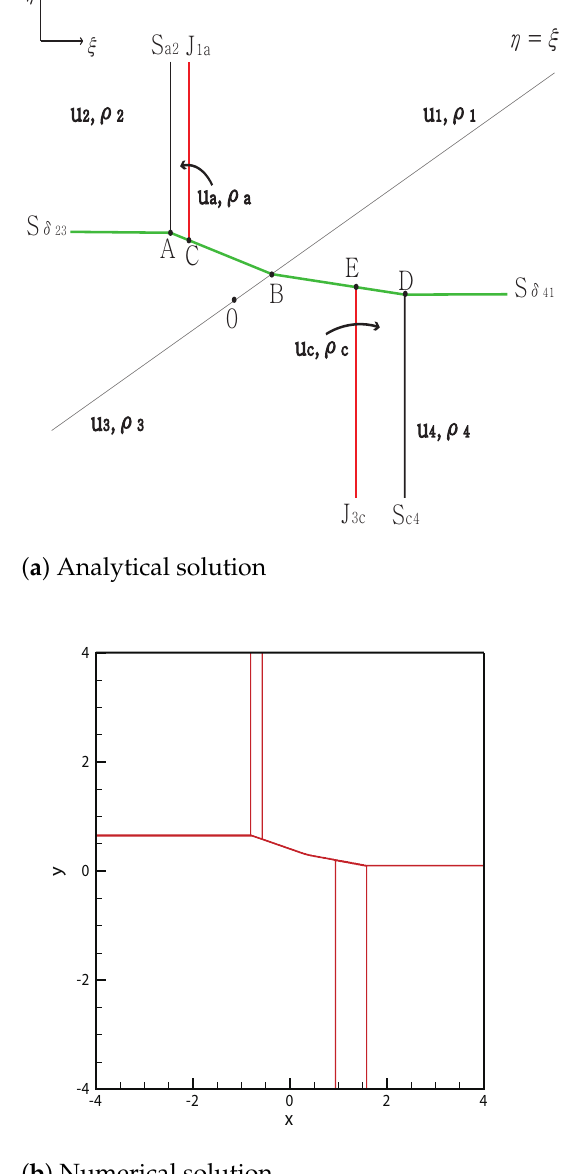
Figure 7. Case 7. JS + S δ + JS + S δ